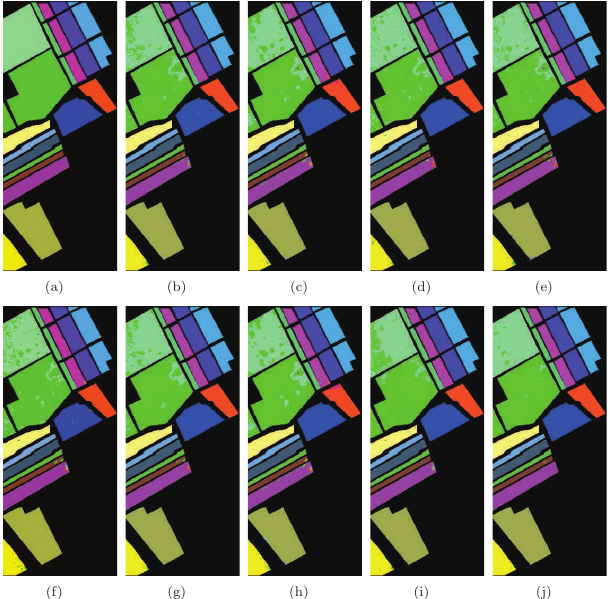
Figure 10. Classification maps of different methods with SVMCK on the Salinas data set. ( a ) Ground truth; ( b ) Baseline (95.8%, 0.954); ( c ) PCA (94.8%, 0.942); ( d ) NPE (96.4%, 0.960); ( e ) LPP (96.0%, 0.955); ( f ) SDE (95.5%, 0.950); ( g ) LFDA (96.3%, 0.958); ( h ) MMC (94.7%, 0.941); ( i ) MFA (95.5%, 0.950); ( j ) LGSFA (99.2%, 0.991). Note that OA and KC are given in